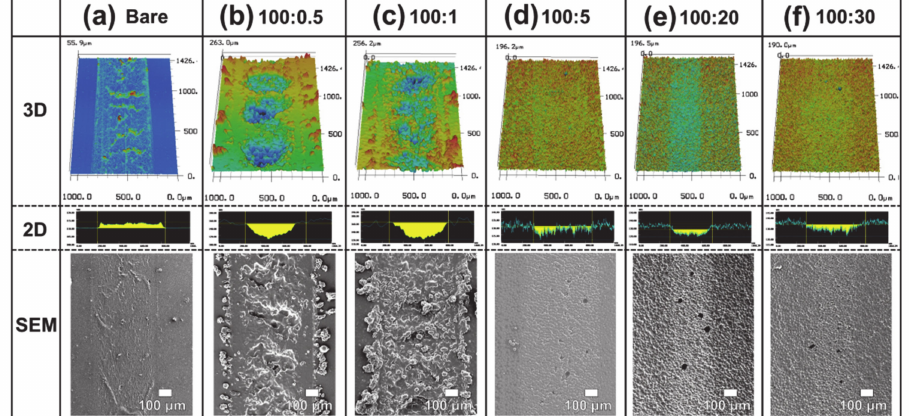
Figure 6. Laser scanning confocal microscope(2D/3D profiles) and SEM images of wear tracks with respect to PDMS:GB mixing ratio: ( a ) bare, ( b ) 100:0.5, ( c ) 100:1, ( d ) 100:5, ( e ) 100:20, and ( f )